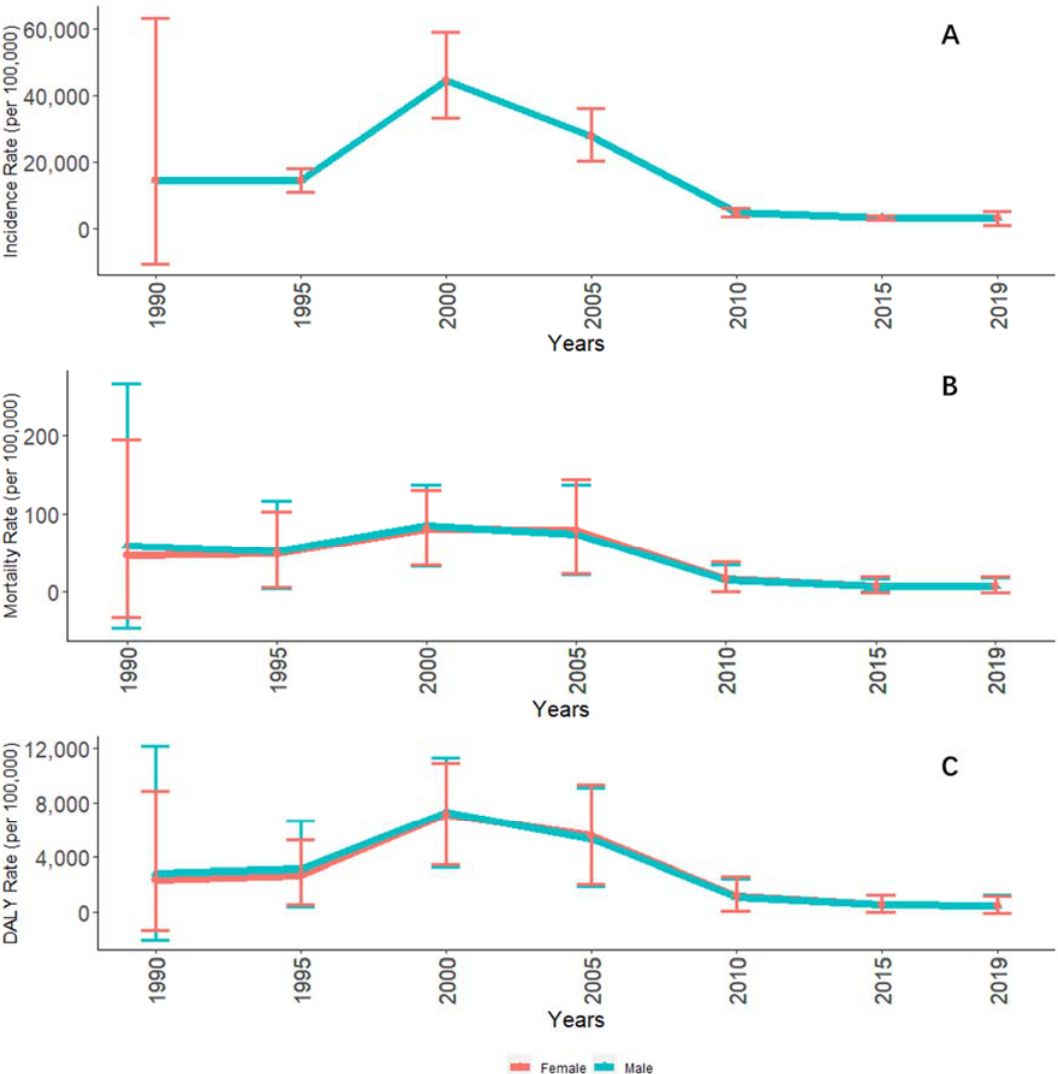
Figure 7. Age-standardized malaria incidence, mortality, and DALY rate in males and females in STP between 1990 and 2019. Note: ( A ) Incidence, ( B ) Mortality, ( C ) DALYs per 100,000 inhabitants from 1990 to 2019.